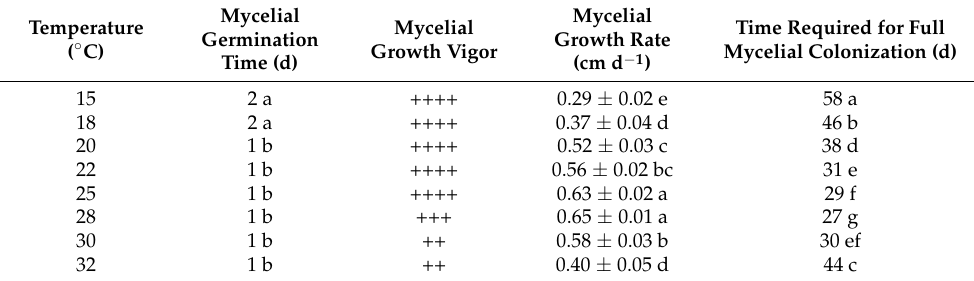
Table 1. Effects of mycelial culture temperature on the mycelial growth of P. ostreatus .